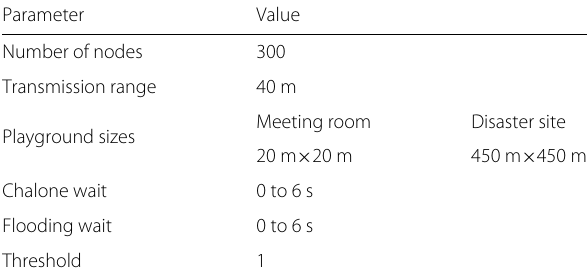
Table 13 Simulation parameters for experiments in realistic wireless conditions